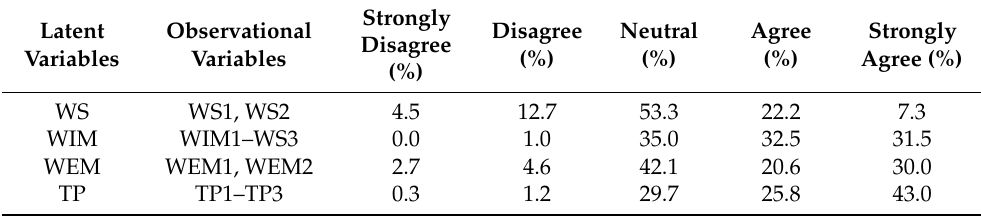
Table A2. Responses to latent variables for the young workers’ group (Group A).